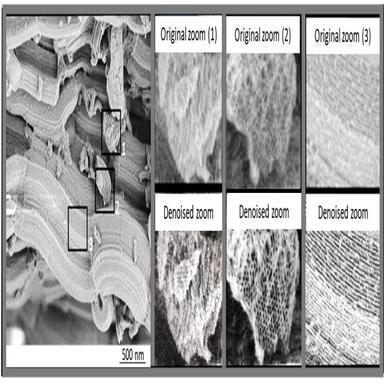
SLEEM images supported by deep learning, showing selected details before and after "denoising" and also image sharpness/resolution improvement.. The latter images show a much better resolution, demonstrating the advantages of deep learning (or SLEEM + deep learning).